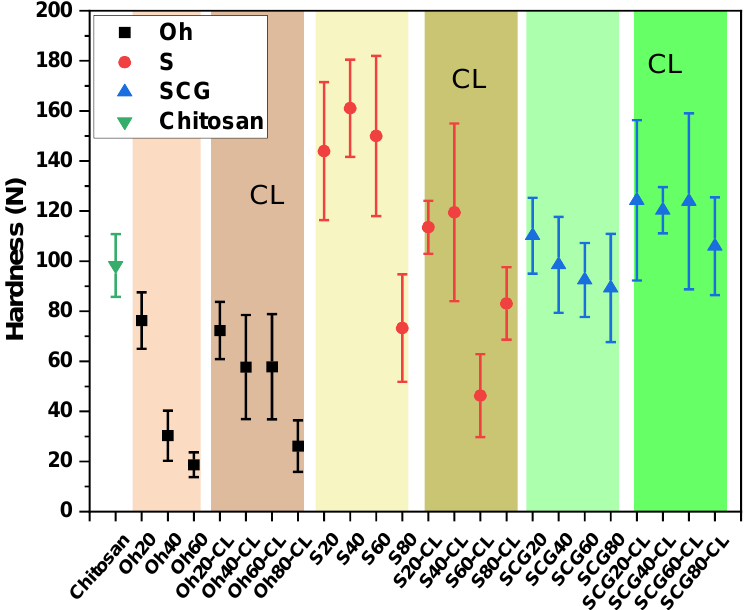
Figure 3. Hardness of the Oh-, S-, and SCG-pellet systems compared to